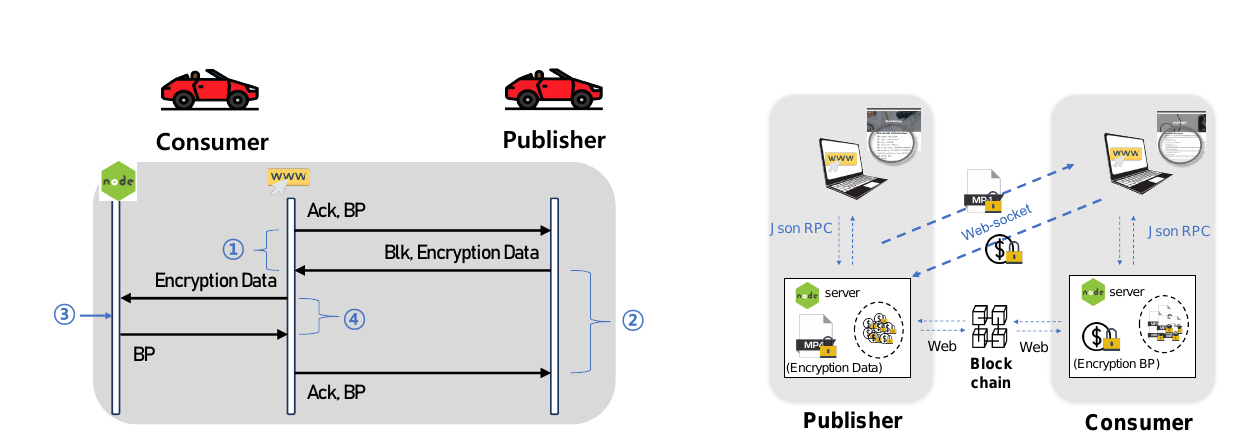
( b ) Implementation details of the off-chain transaction. Figure 8. Implementation of the autoCoin